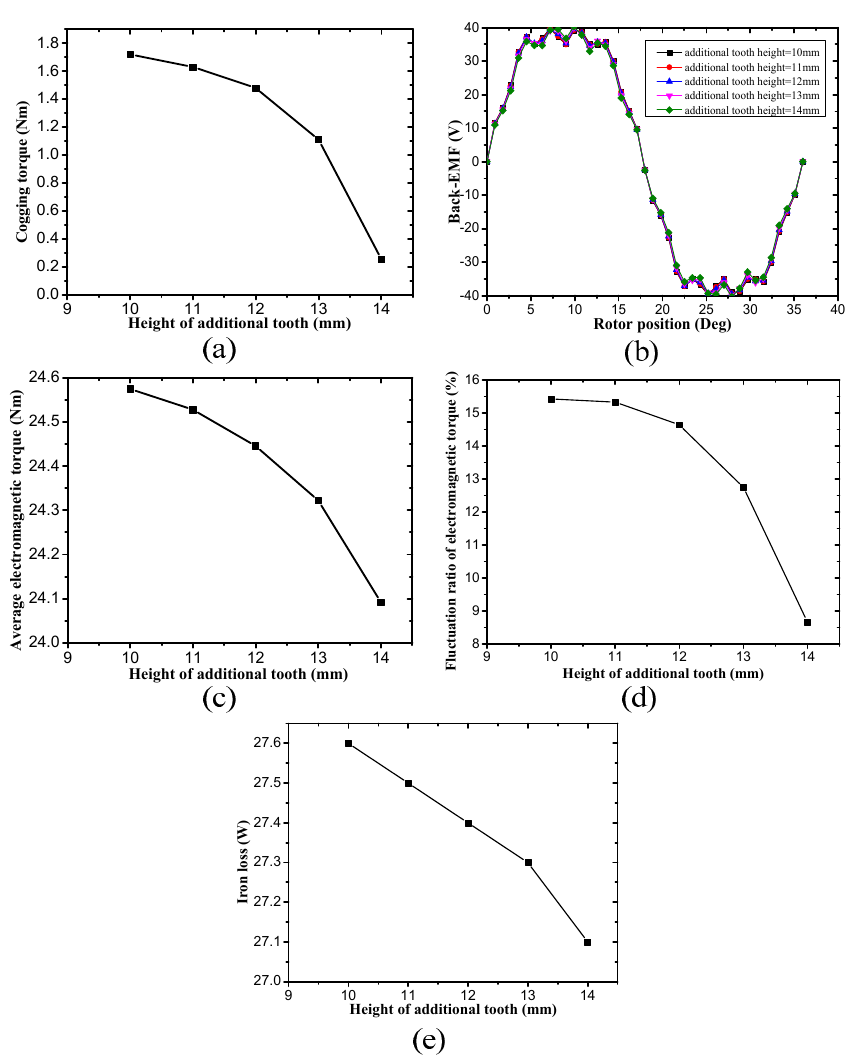
Figure 13. Influence of the additional tooth height ( a ) Cogging torque ( b ) Back—EMF ( c ) Average electromagnetic torque ( d ) Fluctuation ratio of electromagnetic torque ( e ) Iron loss.